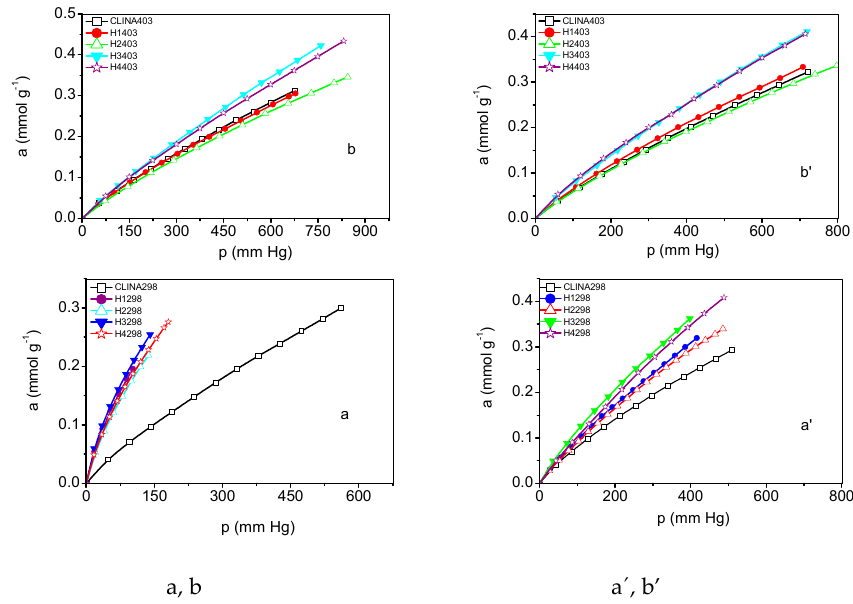
Figure 6. N 2 (a, a’) and O 2 (b, b’) adsorption isotherms at 298 K, and 403 K.